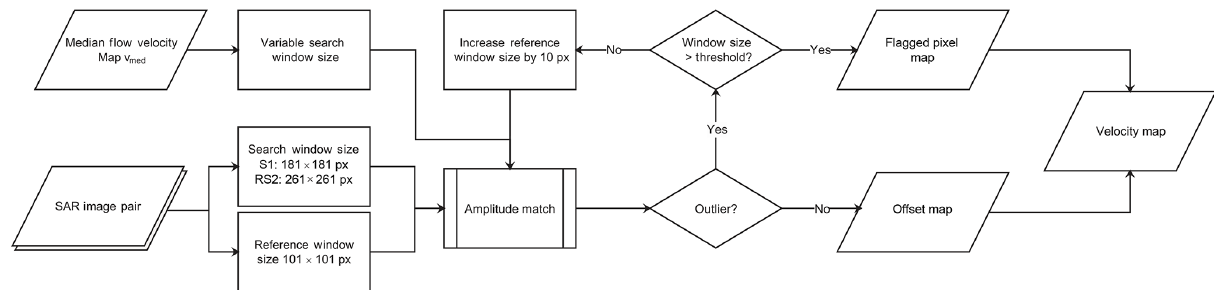
Figure 2. Amplitude match methodology for 12d Sentinel-1A SAR products. The same methodology was used for RADARSAT-2 image pairs but with an increased search window size of 261 pixels × 261 pixels to accommodate the 24d repeat orbit.